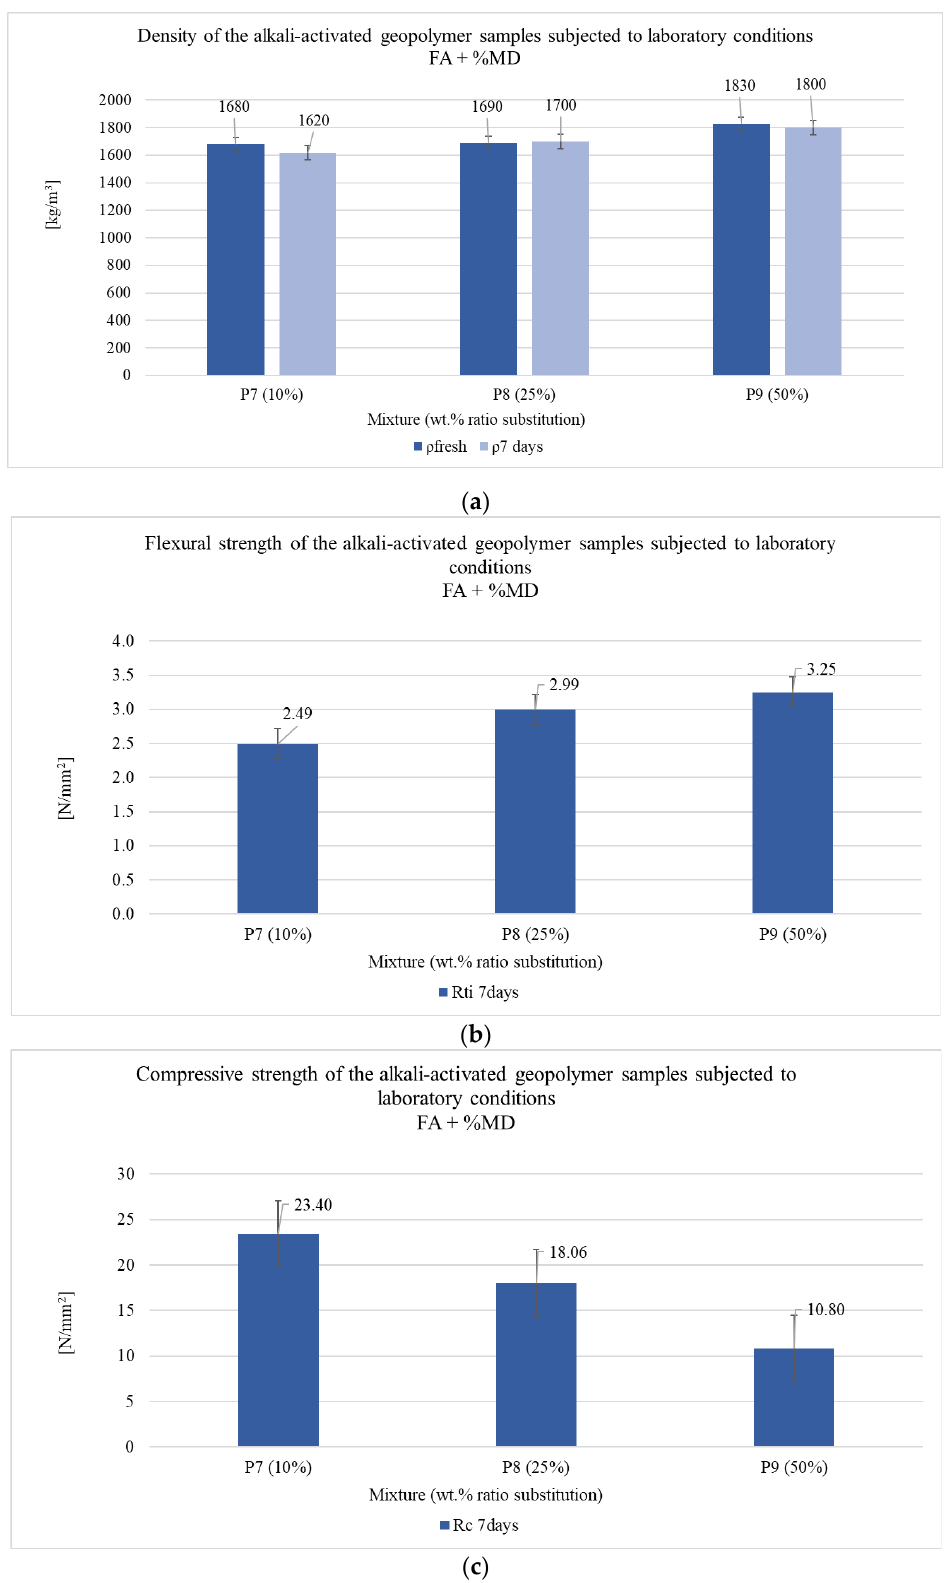
Figure 3. Physico-mechanical performances of the alkali-activated geopolymer binder using MD as FA substitution subjected laboratory conditions: ( a ) Apparent density; ( b ) Flexural strength and ( c ) Compressive strength.